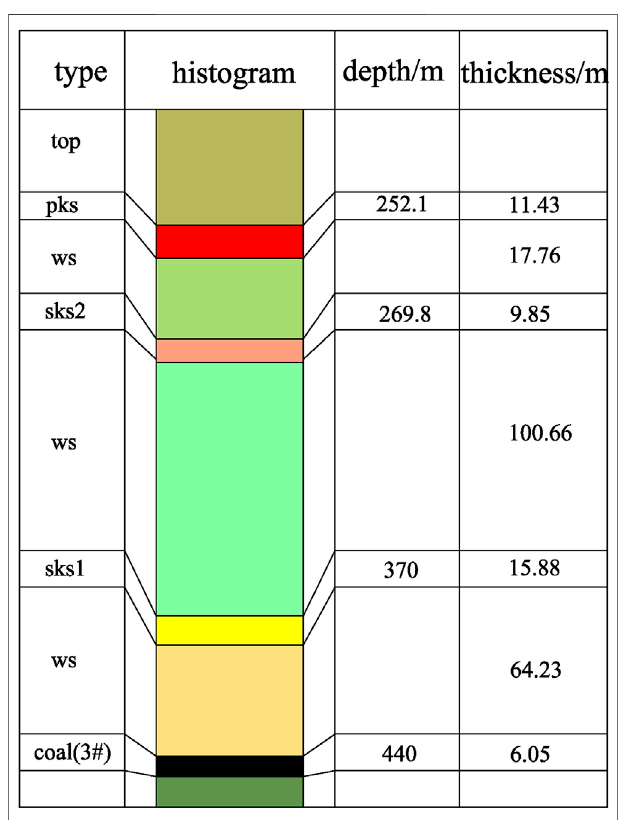
FIGURE 9 | Key strata occurrence of the Xiadian coal mine (partial).